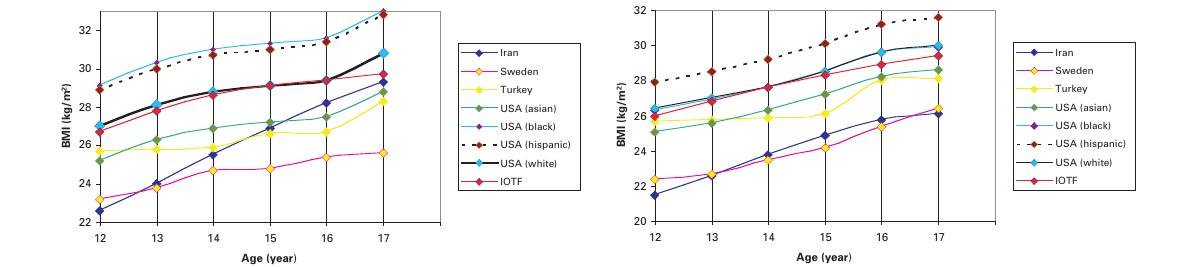
Figure 1 Comparison of the 95 th percentile of BMI values in adoles- cent girls from various parts of the world [11, 13–16].